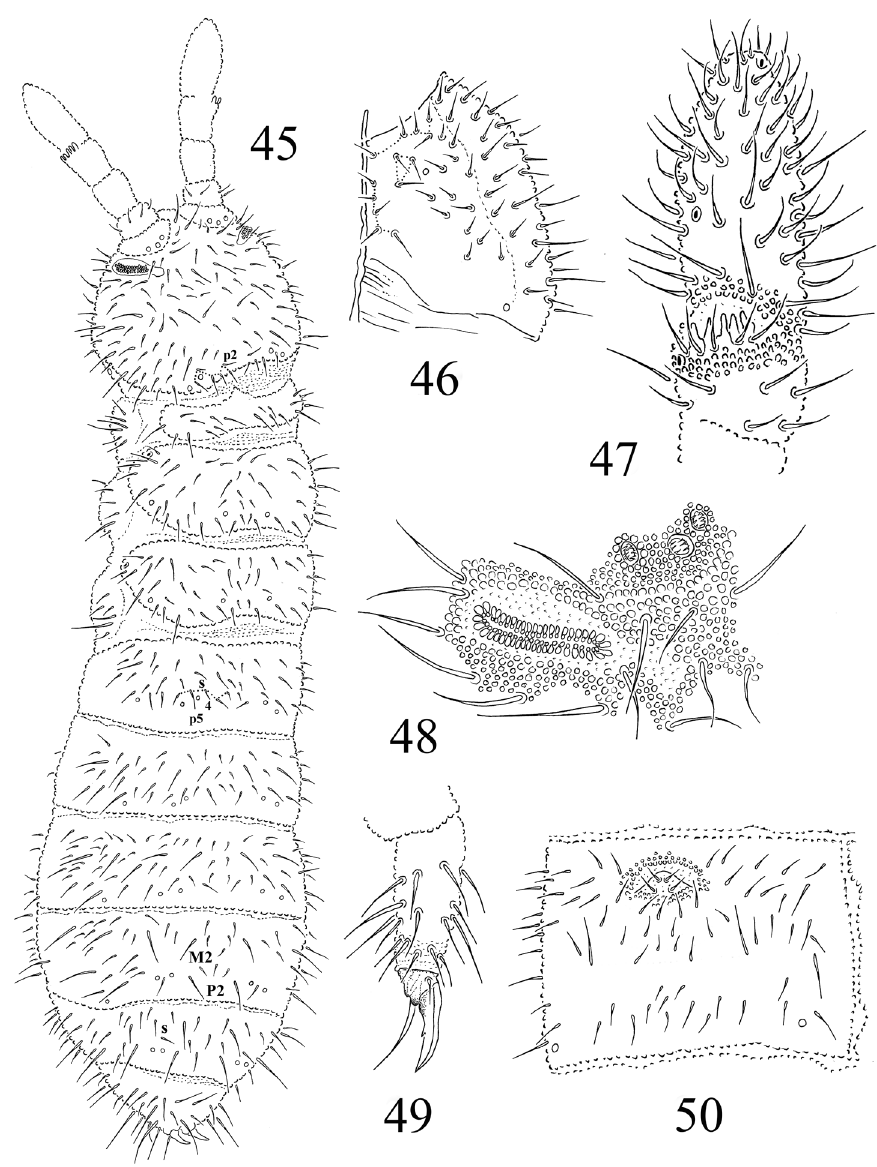
Figures 45–50. Protaphorura tuvinica : 45 habitus and dorsal chaetotaxy 46 right part of head ventrally 47 dorsal side of Ant. III-IV 48 PAO and anterior cephalic pseudocelli 49 tibiotarsal chaetotaxy and claw of leg III 50 chaetotaxy of Abd. sternum